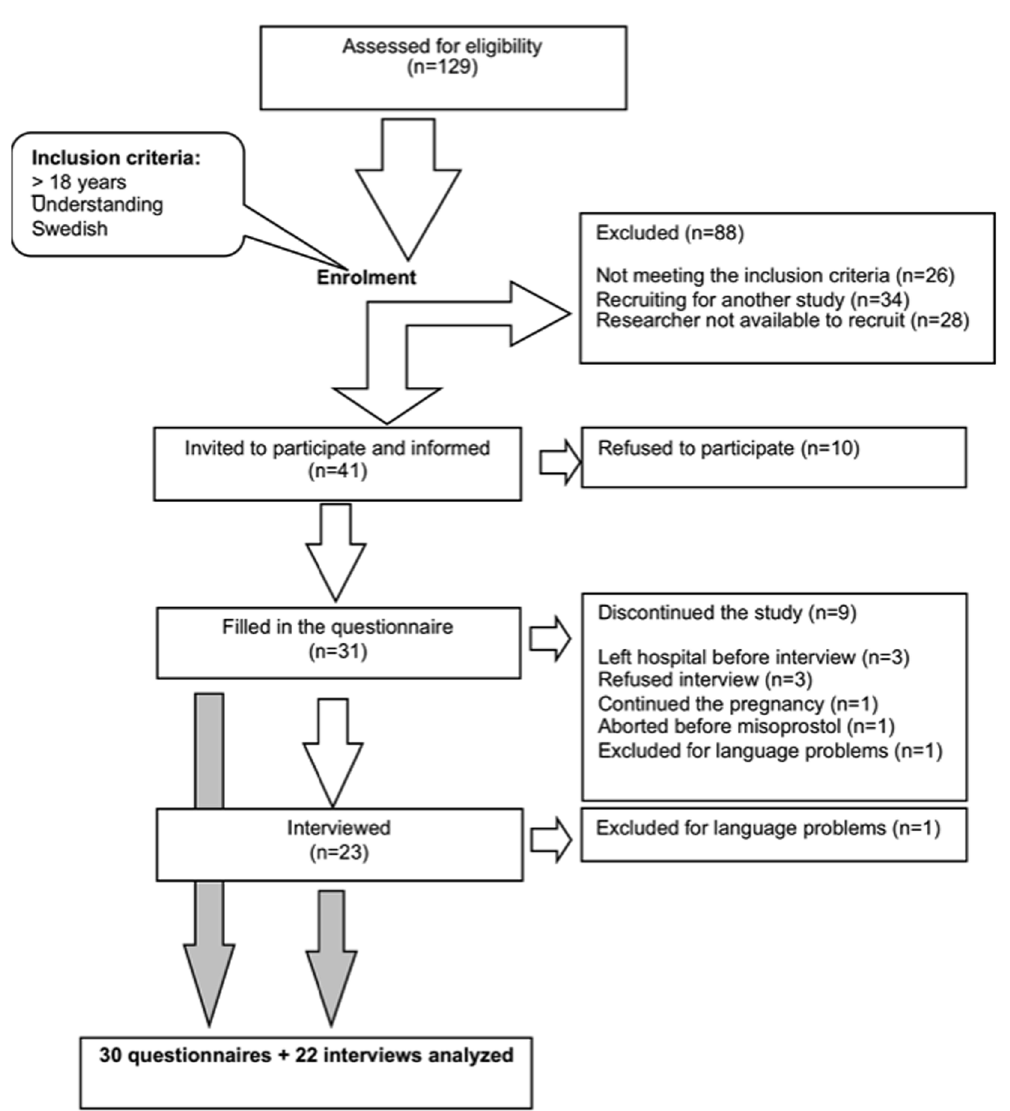
Fig. 1. Flowchart describing the participants.